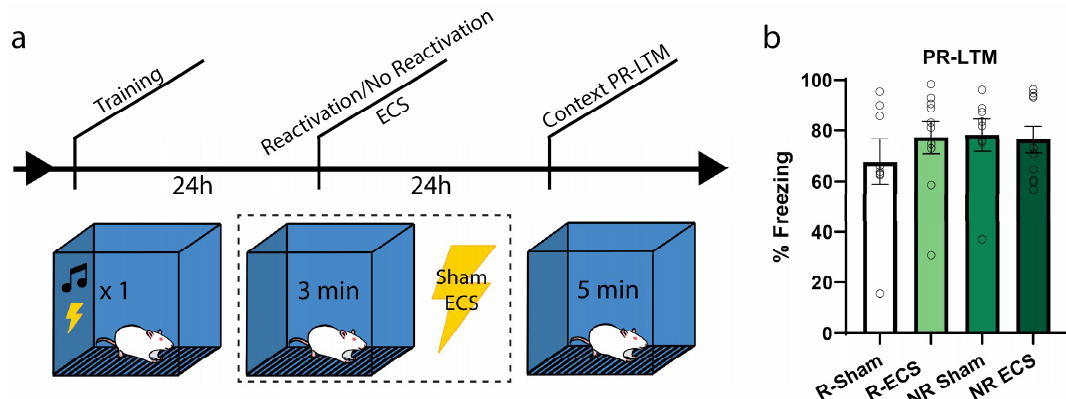
Figure 3. ECS causes no reactivation-dependent deficits of a contextual fear memory. ( a ) After training, two groups were subjected to a reactivation session followed by ECS or sham stimulation, while the remaining two groups received stimulation without memory reactivation. ( b ) There was no di ff erence in freezing between the groups at PR-LTM ( b ). Error bars =